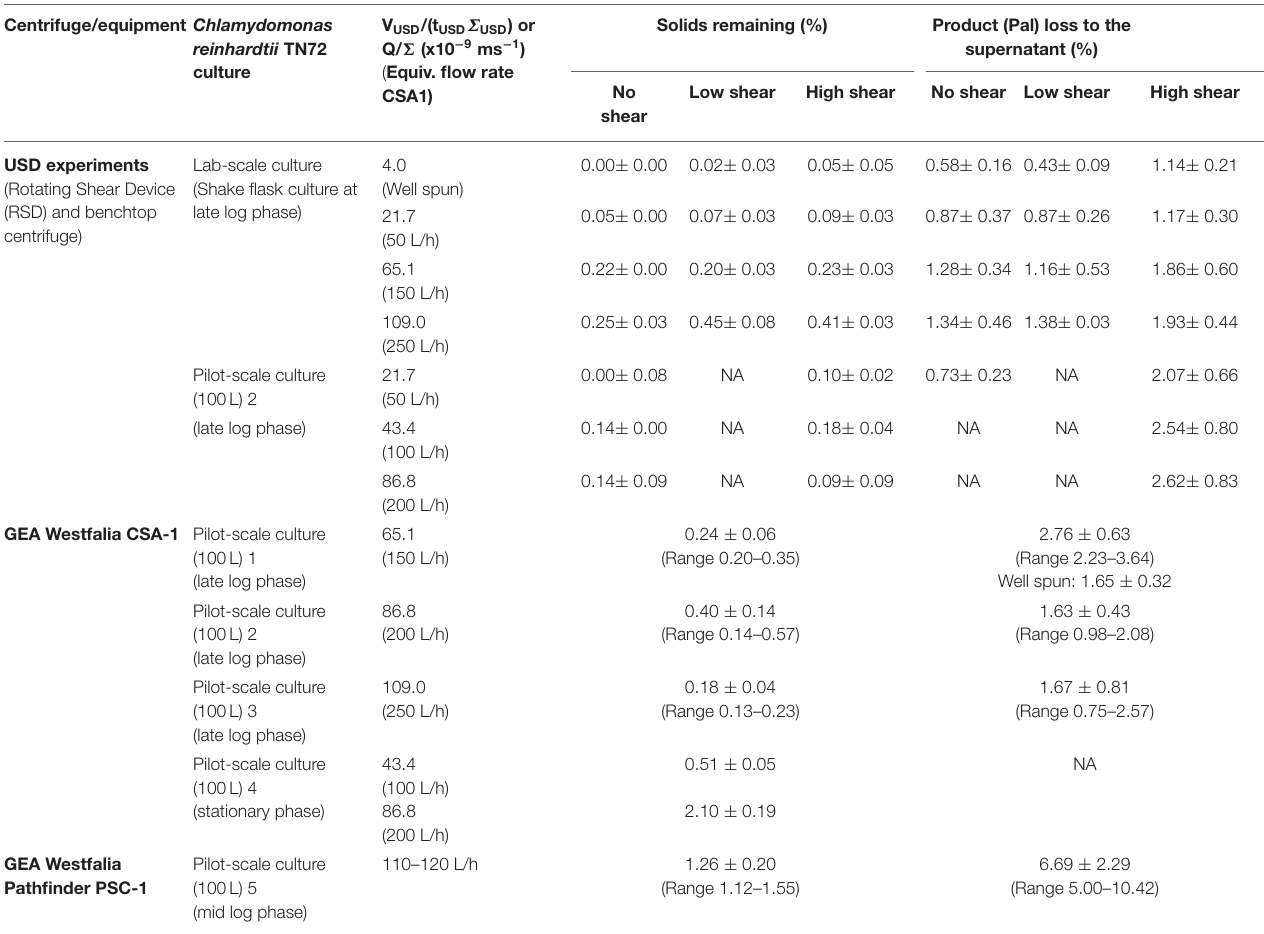
TABLE 1 | Comparison of solids remaining (%) and product loss (%) between ultra-scale-down (USD) experiments and continuous-flow, intermittent-discharge disc-stack centrifugation. Centrifuge/equipment Chlamydomonas reinhardtii